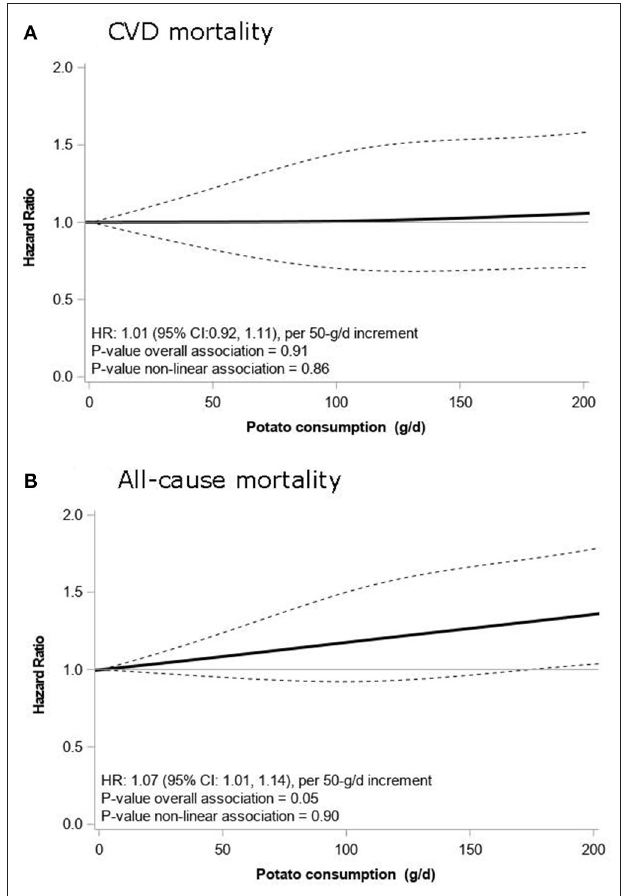
FIGURE 1 | Associations of total potato intake with CVD mortality (A) and all-cause mortality (B) in 3,401 patients from the Alpha Omega Cohort. Lines are restricted cubic splines, showing continuous associations, with 3 knots located at the 5th, 50th, and 95th percentiles. The y-axis shows the predicted hazard ratios (HRs) for mortality for any value of total potato intake, compared to the reference value set at 0 g/d. HRs are adjusted for age, sex, energy intake, education level, smoking, physical activity level, alcohol intake, whole and refined grains, fish, red and processed meat, milk, yogurt and custard, vegetables, fruits, mayonnaise, saturated fatty acids, polyunsaturated fatty acids, sugar-sweetened beverages, sweet and sour snacks and nuts, seeds, and legumes. CVD, cardiovascular disease; HR, hazard